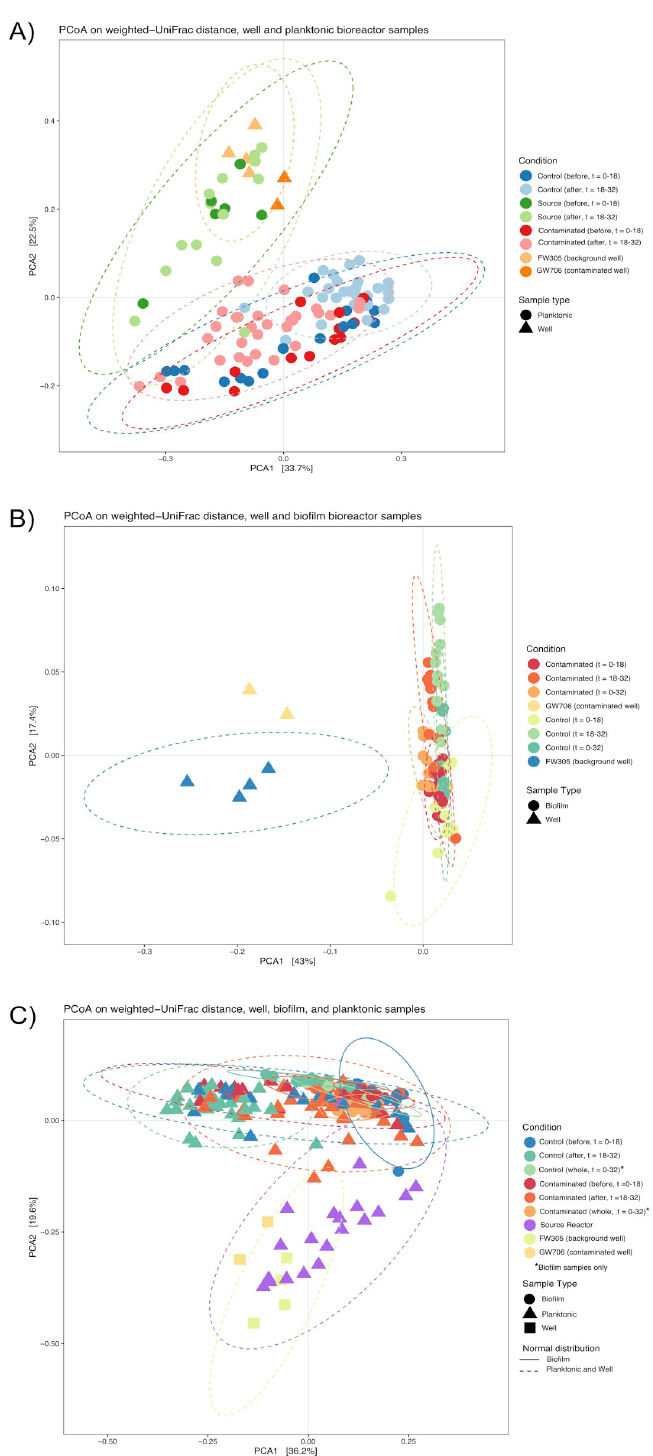
Fig 4. PCoA plots of weighted Unifrac distances showing variation in 16S rRNA OTU relative abundance in A) planktonic communities from control (background, FW305 receiving) and contaminated (receiving GW706 water) reactors sampled before the switch on day 18, and after the switch to contaminated water (days 18–32); and B) biofilm communities collected after the first 18 days of incubation (0–18), the last 14 days of incubation (18–32), or all 32 days of incubation (0–32). C) planktonic, biofilm, well (background site FW305 and contaminated well GW706), and